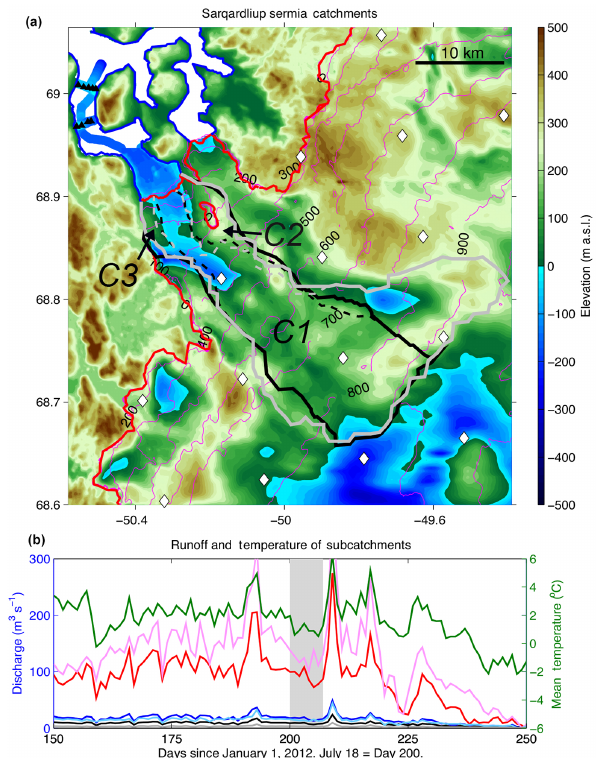
Figure 7. Saqqarliup sermia catchments and discharge. (a) Es- timated Saqqarliup sermia catchment (thick black line) and sub- catchments C1, C2, and C3 (dashed black line) from the MBM2014 analysis over Morlighem et al. (2014) bedrock elevation map (filled contours) and ice sheet surface (magenta contours). BBM2013 catchment and subcatchments outlines in thick solid and dashed grey lines, respectively. Ice sheet margin and coastlines shown in red and blue, respectively. RACMO2.3 11km resolution grid points shown with white diamonds. Sarqardleq Fjord bathymetry and outer Sarqardleq Fjord CTD positions (black triangles) and depth measurements also shown. (b) Daily C1, C2, and C3 sub- catchment MBM2014 RACMO2.3 discharge estimates (red, blue, and black lines, respectively) and daily average RACMO2.3 tem- perature (green line) across the Saqqarliup sermia subcatchment C1 for DOY 150–250, 2012. Daily C1, C2, and C3 subcatchment BBM2013 RACMO2.3 discharge estimates in pink, cyan, and grey lines, respectively. Dates of REMUS and CTD sampling from DOY 200–207 marked by grey